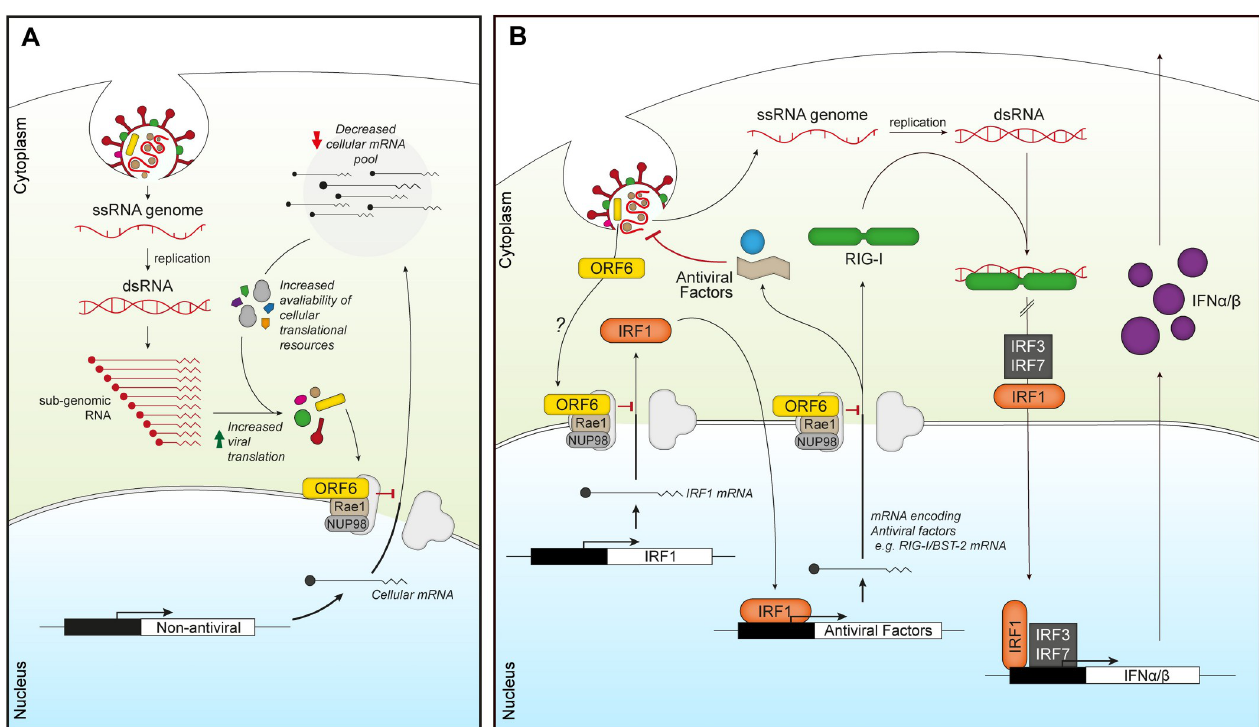
Fig 6. ORF6 inhibits mRNA export to favour viral translation and supress innate signalling. (A) Incoming or expressed ORF6 (yellow rectangles) binds to the Rae1-Nup98 complex (grey/brown) blocking the export of cellular mRNA (black lines). This subsequently reduces the cellular mRNA pool, increasing the availability of cellular translational machinery for viral translation as well as decreasing the expression of cellular proteins. (B) Incoming or expressed ORF6 (yellow) binds to the Rae1-Nup98 complex (grey/brown), inhibiting export of cellular mRNA encoding IRF1 (orange). This prevents the translation of IRF1, blocking IRF1 regulation of the transcription of additional steady state antiviral factors, like RIG-I and BST-2. ORF6 also inhibits nuclear export of mRNA encoding RIG-I (green), preventing detection of viral dsRNA produced during coronavirus replication. This helps reduce IRF1/3/7 activity and subsequent transcription of IFN α / β (purple), which prevents IFN α / β inducing an antiviral state in an autocrine and paracrine manner.